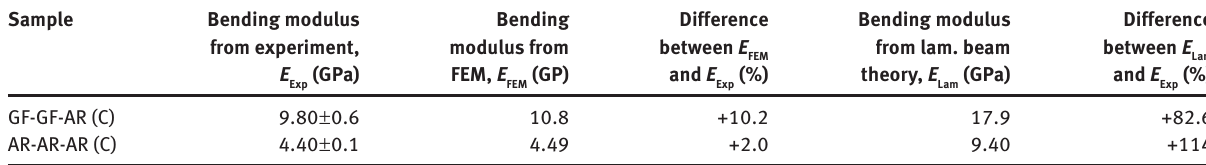
Table 11 Bending modulus results from the experiment, from FEM modeling, and from laminate beam theory in the course (C) direction.